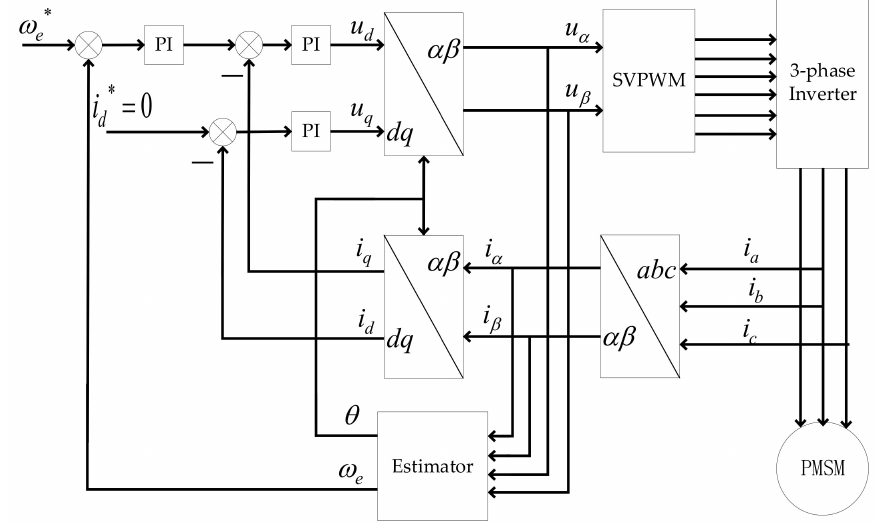
Figure 2. The PMSM speed control and estimation block.